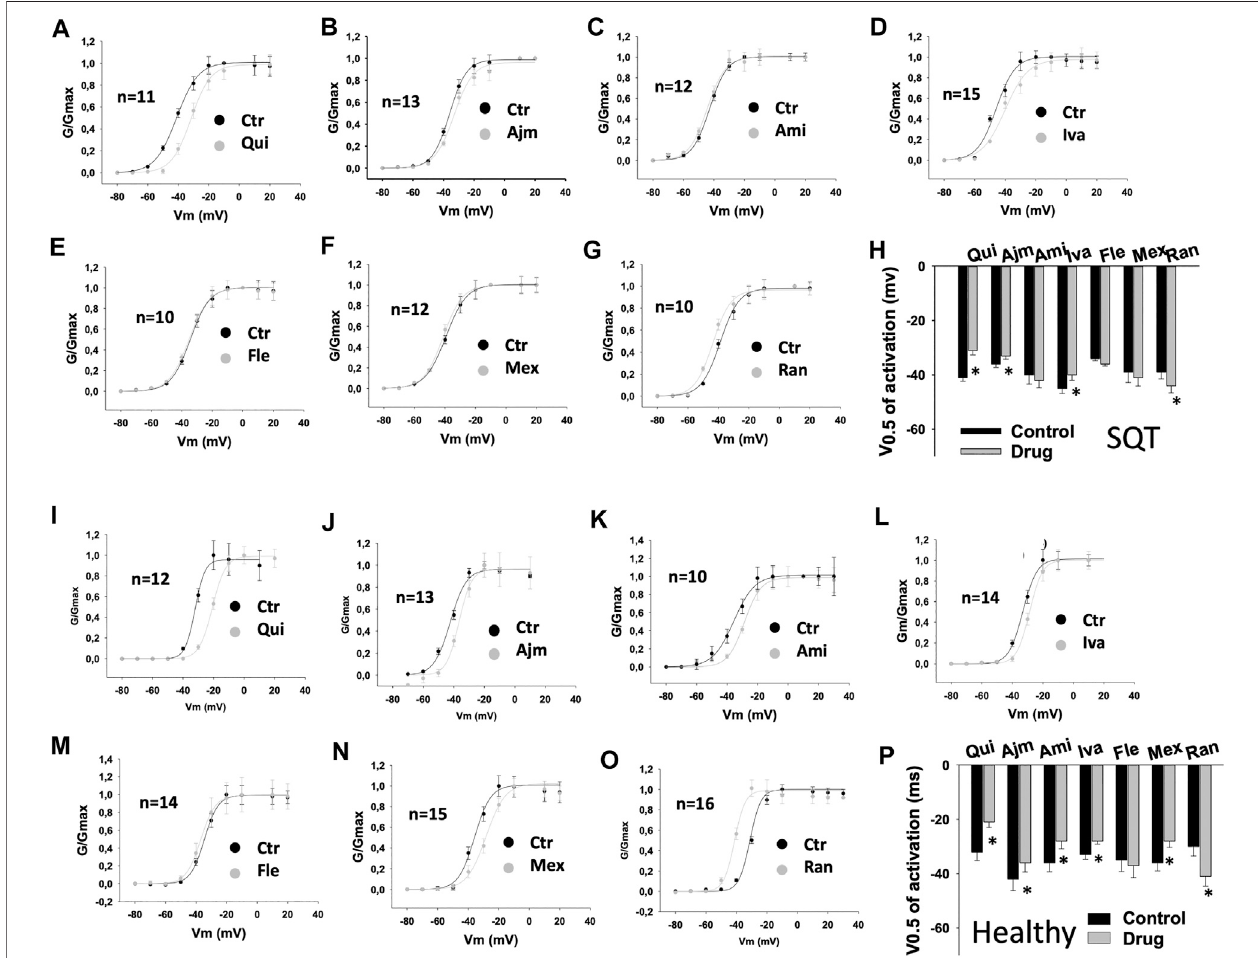
FIGURE3 | Drug effects on voltage-dependentactivation ofI Kr in SQTS1-hiPSC-CMs. I Kr wasevoked by 2 s pulses from − 80to 60 mV (10 mV increments) with a holdingpotentialof − 80 mV.Thesteadystatecurrentsweremeasuredattheendofpulsesasindicatedbyarrowsin Figures1A,B beforeandafterapplicationofadrug. The conductance wascalculated with theequation: G (cid:1) I/V, where I isthemeasured current, Visthe voltage ofpulses and G istheconductance. The conductance was normalizedtothemaximum(G/Gmax) andplottedagainstvoltagetoobtaintheactivation(G-V)curves.Thecurveswere fi ttedbyBoltzmannequationtoobtainthe voltage value at halfmaximal activation (V0.5). (A – G) Activation curves ofI Kr in SQT1-hiPSC-CMs in absence (Ctr) and presence of quinidine (Qui, 10 µM), ajmaline (Ajm, 30 µM), amiodarone (Ami, 10 µM), ivabradine (Iva, 10 µM), fl ecainide (Fle, 30 µM), mexiletine (Mex, 100 µM) and ranolazine (Ran, 30 µM). (H) Averaged values of half maximal activation potential (V0.5) in SQT1-hiPSC-CMs in absence (Ctr) and presence of drugs. (I – O) Activation curves of I Kr in donor-hiPSC-CMs in absence (Ctr) and presence of quinidine (Qui, 10 µM), ajmaline (Ajm, 30 µM), amiodarone (Ami, 10 µM), ivabradine (Iva, 10 µM), fl ecainide (Fle, 30 µM), mexiletine (Mex, 100 µM) and ranolazine(Ran,30 µM). (P) Averaged valuesofhalfmaximal activationpotential(V0.5) indonor-hiPSC-CMs inabsence (Ctr)and presence ofdrugs. Shown aremean ± SEM, n represents number of cells. The statistical signi fi cance was examined by paired t-test, * p < 0.05 versus